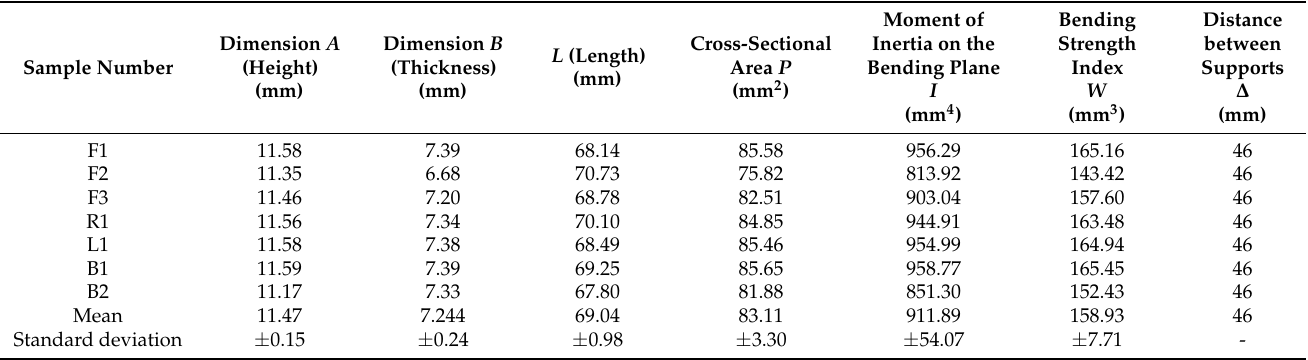
Table 2. Dimensions, mass properties, and support spacing for samples in the three-point bending test.